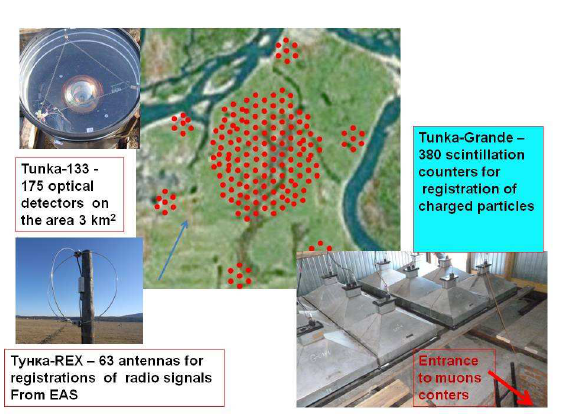
Figure 1. The EAS array complex for study of cosmic rays with E ≥ 10 15 eV in Tunka Valley